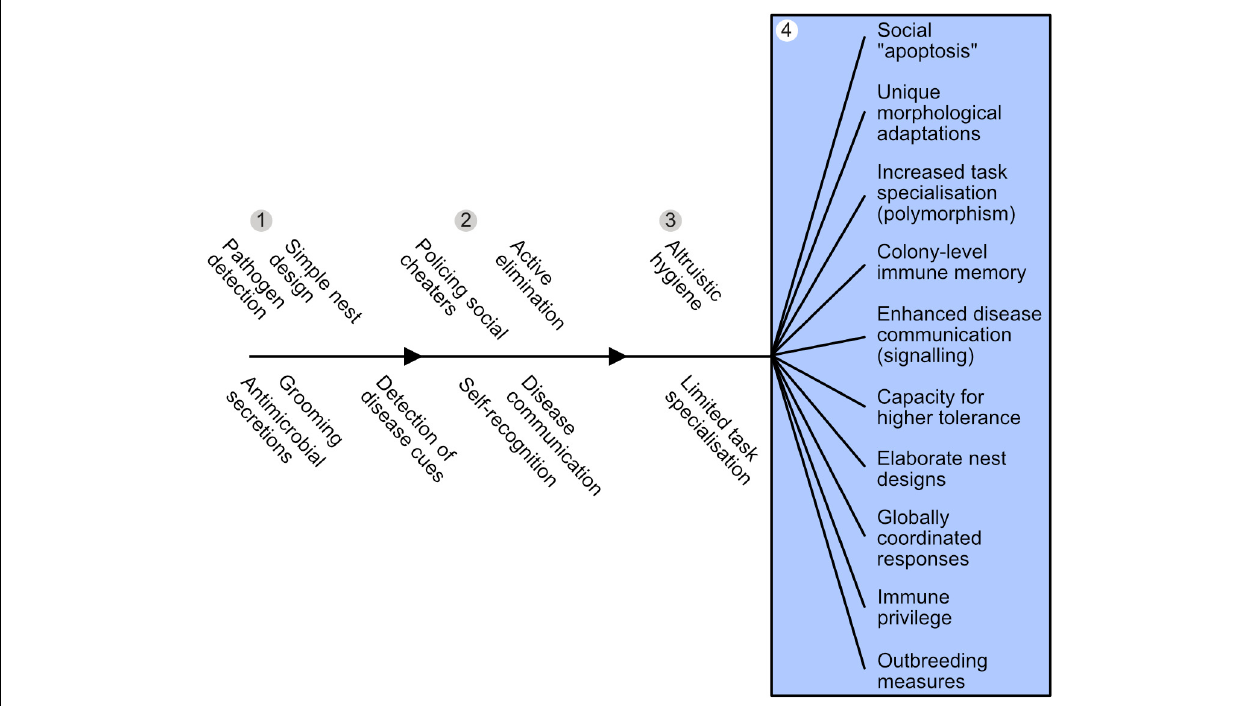
FIGURE 4 | Emergence and diversification of superorganism immunity. Adaptations that may have evolved prior to – and thus enabled – the transition to superorganismality are listed in the order we hypothesize they might appear, as an insect family approaches superorganismality. Colony-level immunity undergoes a systemic diversification and specialization to become a social immune system in superorganisms (blue box) that is functionally equivalent to an individual immune system. (1) Numerous pre-adaptions present in subsocial ancestors, such as pathogen detection, grooming and antimicrobial use, may have facilitated initial insect cooperation. (2) As insect family groups become larger and more interdependent, adaptations are predicted to evolve to counter the increased risk of disease inherent to kin-structured groups living in close social proximity, i.e., detection and/or elimination of sick family members (e.g., either avoidance or cannibalism/exclusion from nest). Additionally, mechanisms to police social cheaters and allorecognition should emerge to maintain social stability. (3) The evolution of altruistic hygiene, where helpers risk survival to augment the fitness of siblings is predicted in species where worker individuals accrue a large but not total proportion of fitness indirectly. Specializations for disease-related tasks are predicted and an incipient social immune system emerges. (4) Where reproductive-worker roles become effectively obligate, social immune systems with corresponding levels of diversification, specialization and intricacy are predicted to emerge (blue